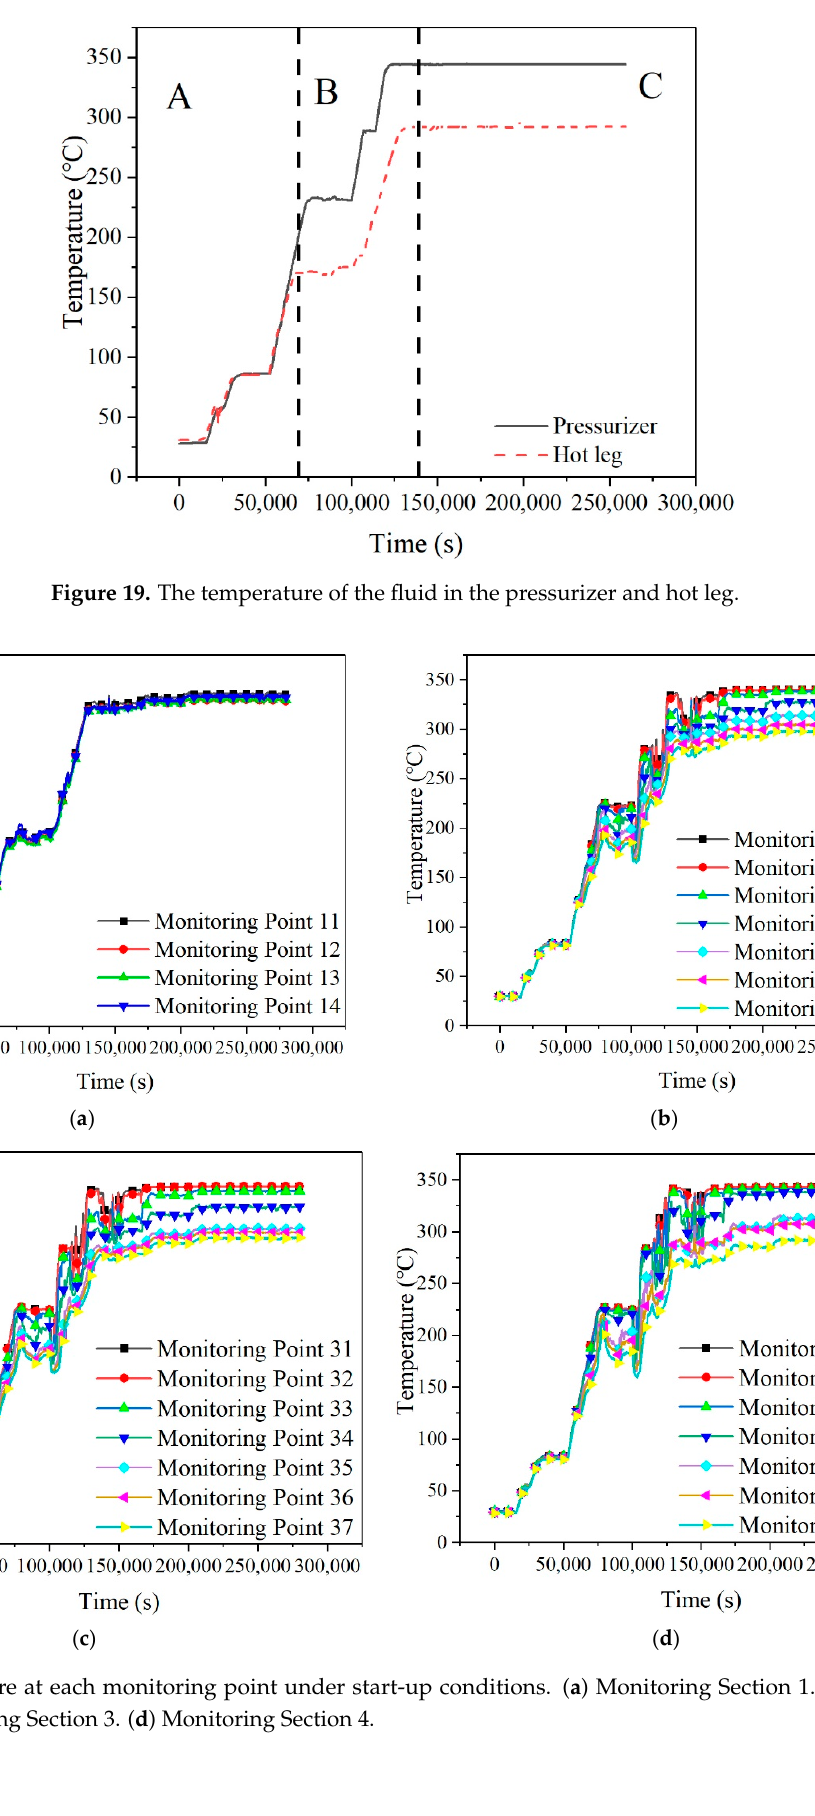
Figure 19. The temperature of the fluid in the pressurizer and hot leg.